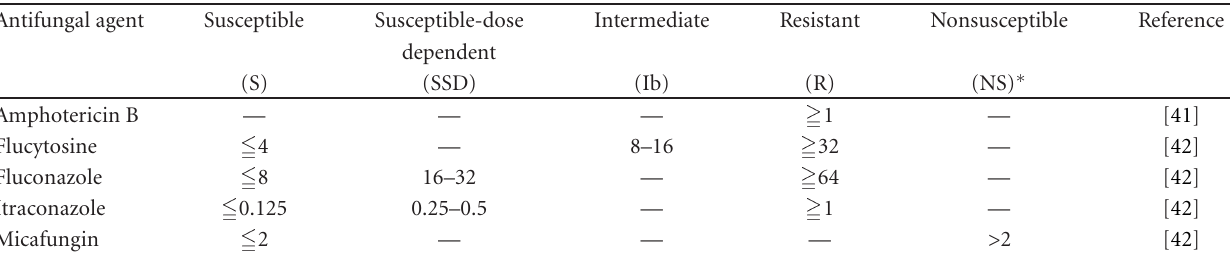
Table 1: Interpretive guidelines for in vitro susceptibility testing of Candida spp. extracted from CLSI guideline.